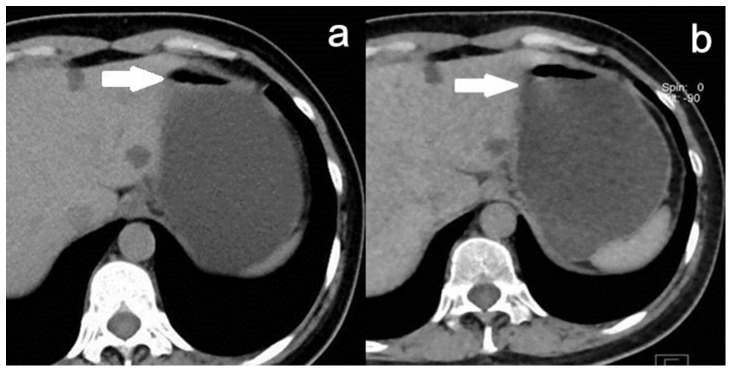
More obvious overshooting artifact at the gas-fluid level (arrow) was detected in VNE image.
a. TNE image; b. VNE image.